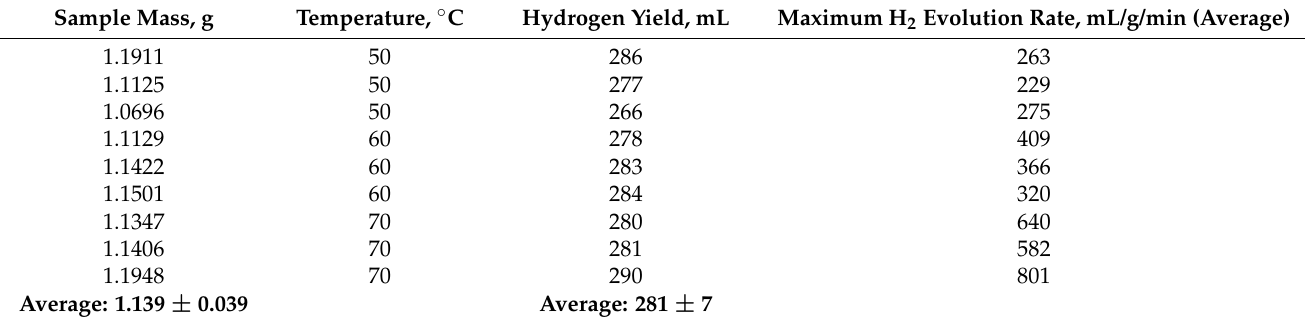
Table 2. Sheet masses, hydrogen yields, and maximum evolution